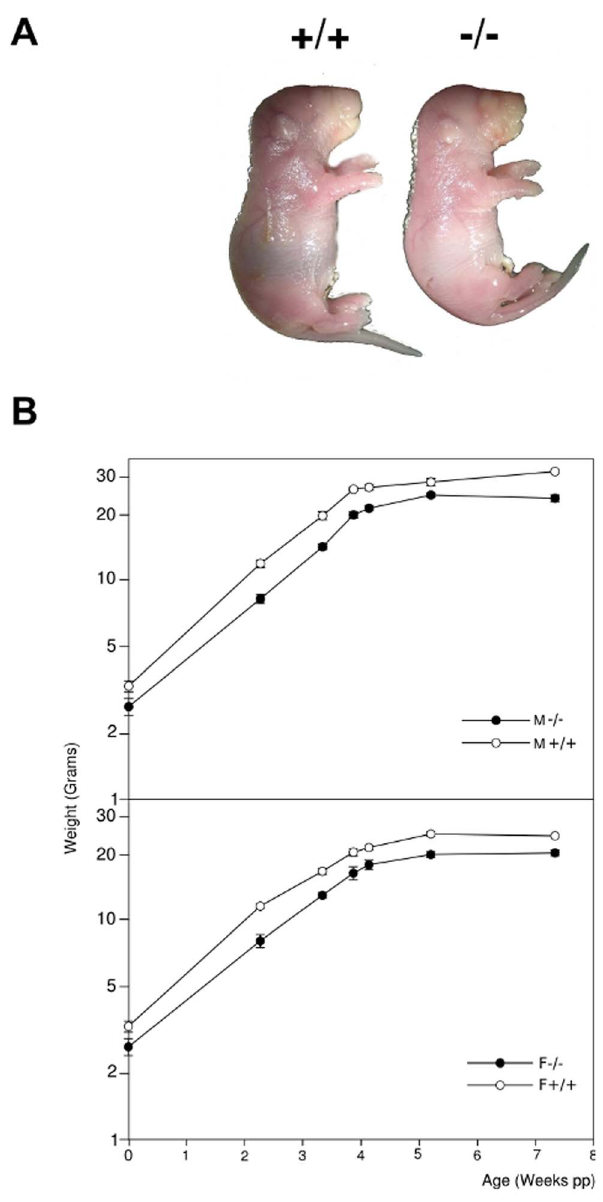
Figure 1. Newborn morphology and growth of BSP + / + and BSP 2 / 2 mice. (A) general aspect of BSP + / + ( + / + ) and BSP 2 / 2 ( 2 / 2 ) newborn mice. (B) Kinetics of weight gain during the growth of BSP + / + and BSP 2 / 2 mice. M, males; F, females. Data are Mean 6 SEM of N=4 to 31 mice. Note the log scale.